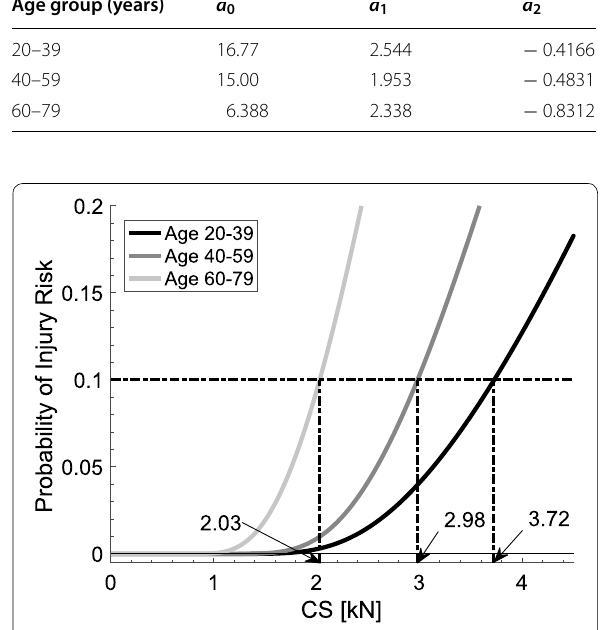
Fig. 5 10% risk level of the risk curves for three generations. CS, compressive